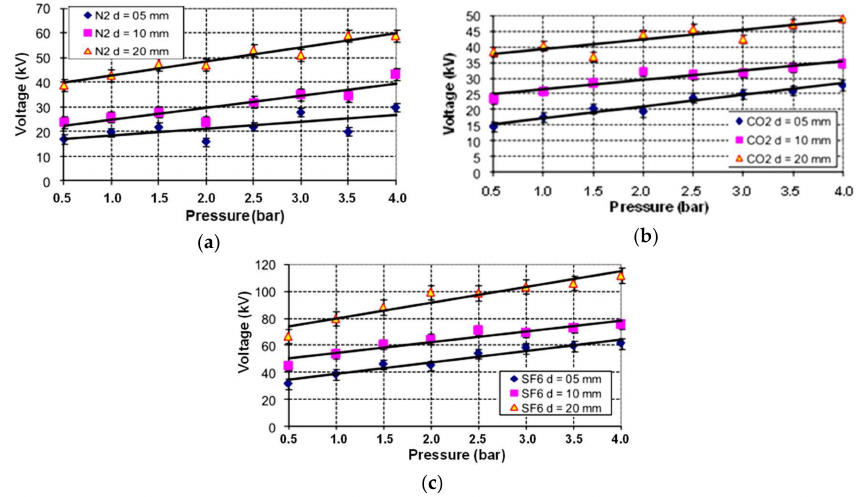
Figure 3. Lightning impulse (LI) breakdown voltage of N 2 ( a ), CO 2 ( b ) and SF 6 ( c ) gases in the point–plane electrode